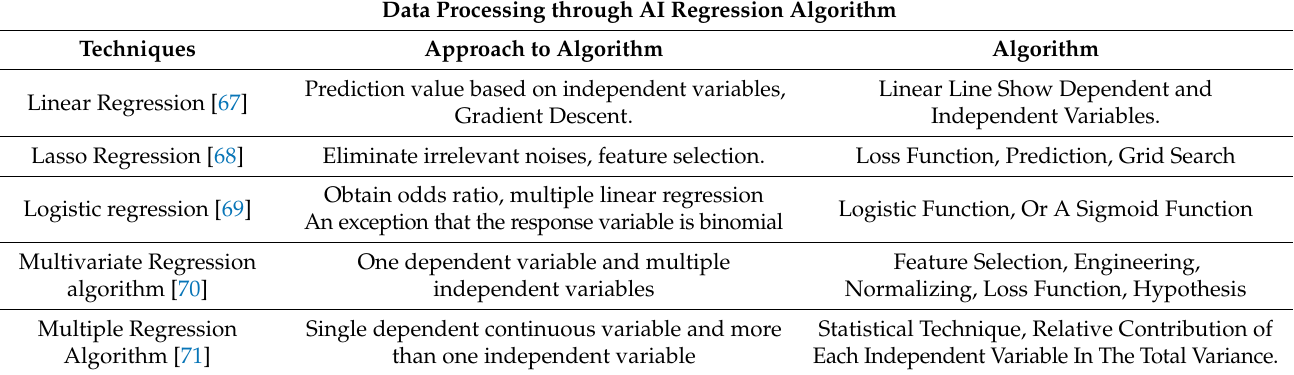
Table 4. AI Regression